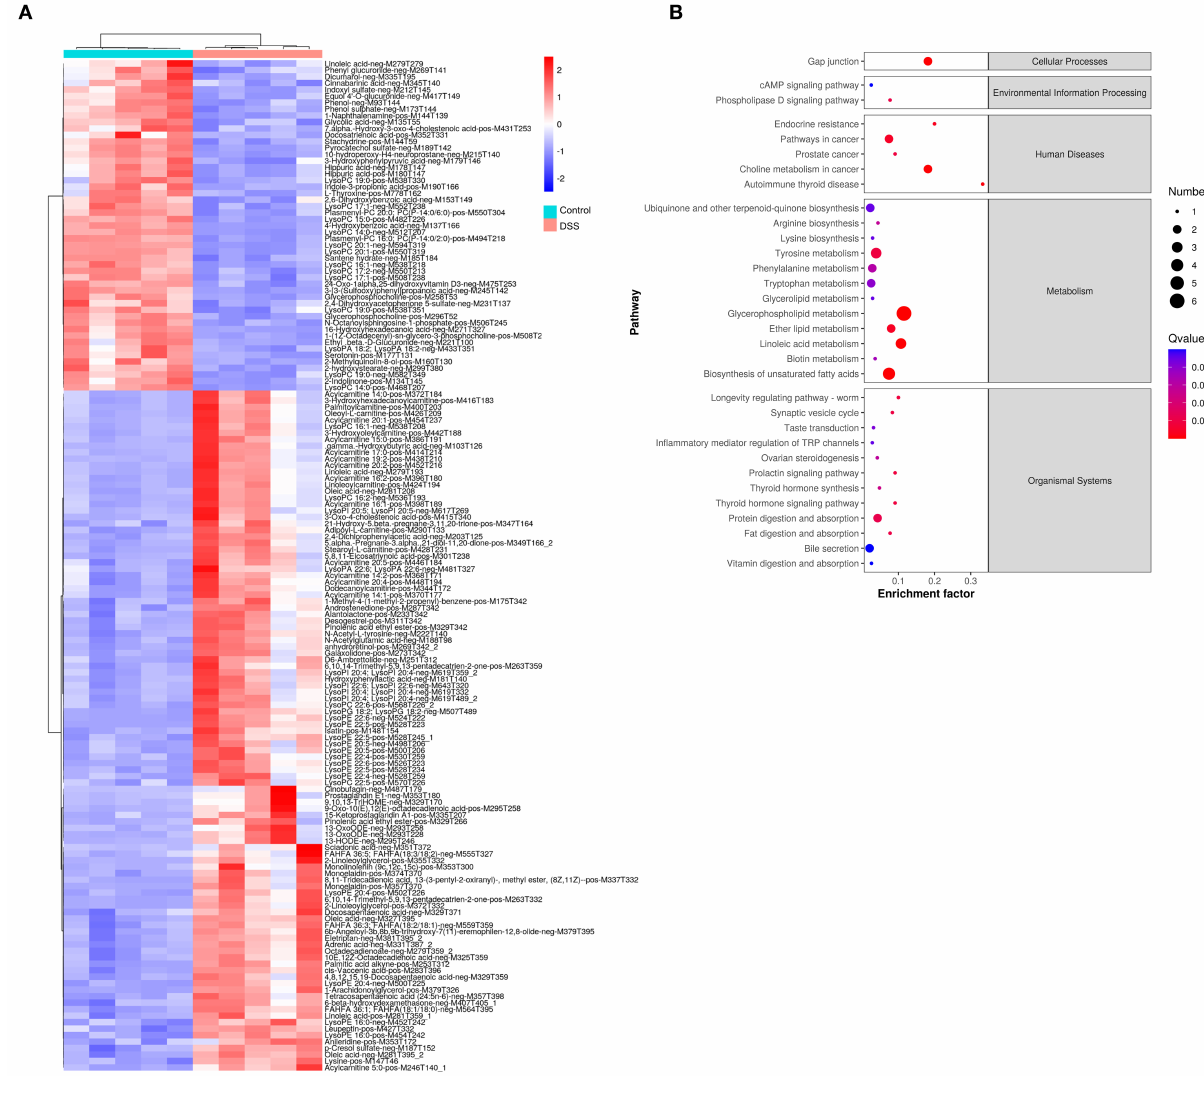
FIGURE 2 | Change of gut metabolites in DSS-induced UC model. (A) Heatmap showed the level of gut metabolites in control group and DSS-induced colitis group. Red color represented the upregulation of metabolites. Blue color represented downregulated metabolites. (B) Rich factor plot showed the alteration of KEGG pathways in DSS-induced UC model. The size of dot represented the number of gene. The color intensity of dot represented the significance of the